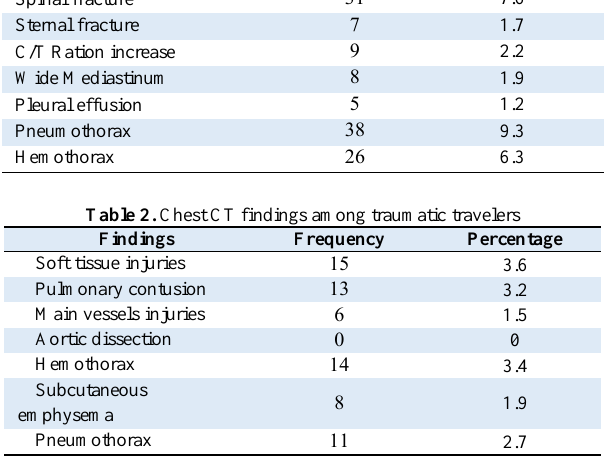
Percentage Frequency Findings